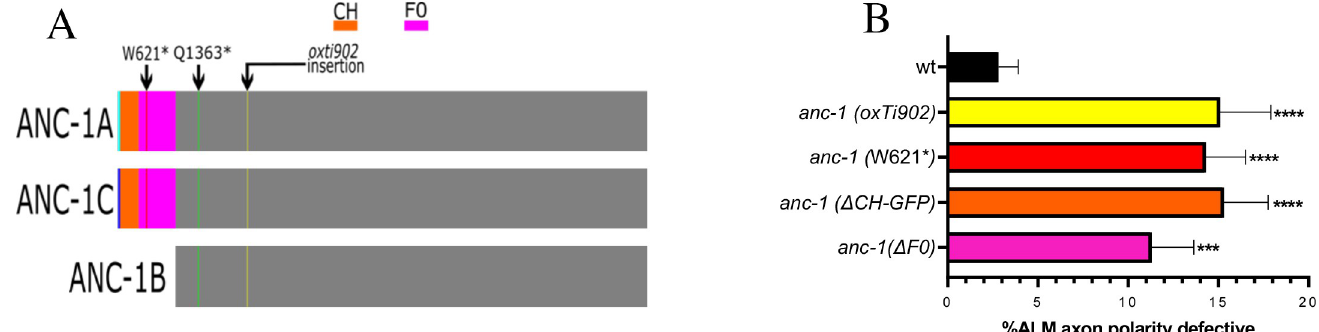
Fig 2. The ANC-1A and ANC-1C isoforms are required for the axon growth-polarizing activity of the anc-1 gene. (A) Diagram of the ANC-1A, ANC-1B and ANC-1C proteins. The W621 � mutation removes function of ANC-1A and ANC-1C and the oxTi902 and Q1363 � mutations remove function of all three isoforms. (B) Quantification of ALM axon polarity defects. The ANC-1A and ANC-1C isoforms are required for the polarization of ALM axon growth. ALM neurons were analyzed in L4 hermaphrodites using the muIs32 transgene that encodes Pmec-7 :: gfp . N > 194 for all genotypes. Asterisks indicate statistically significant difference ( ��� p = .007, ���� p < .0001) relative to wild type, “N-1” Chi-squared test for proportions. Error bars represent the standard error of the proportion. anc-1(W621 � ) is anc-1(gk109018[W621 � ]); anc-1( Δ CH-GFP) is anc-1(yc41[ Δ ch :: gfp3xFLAG :: anc-1]);anc-1( Δ F0) is anc-1(syb5659)